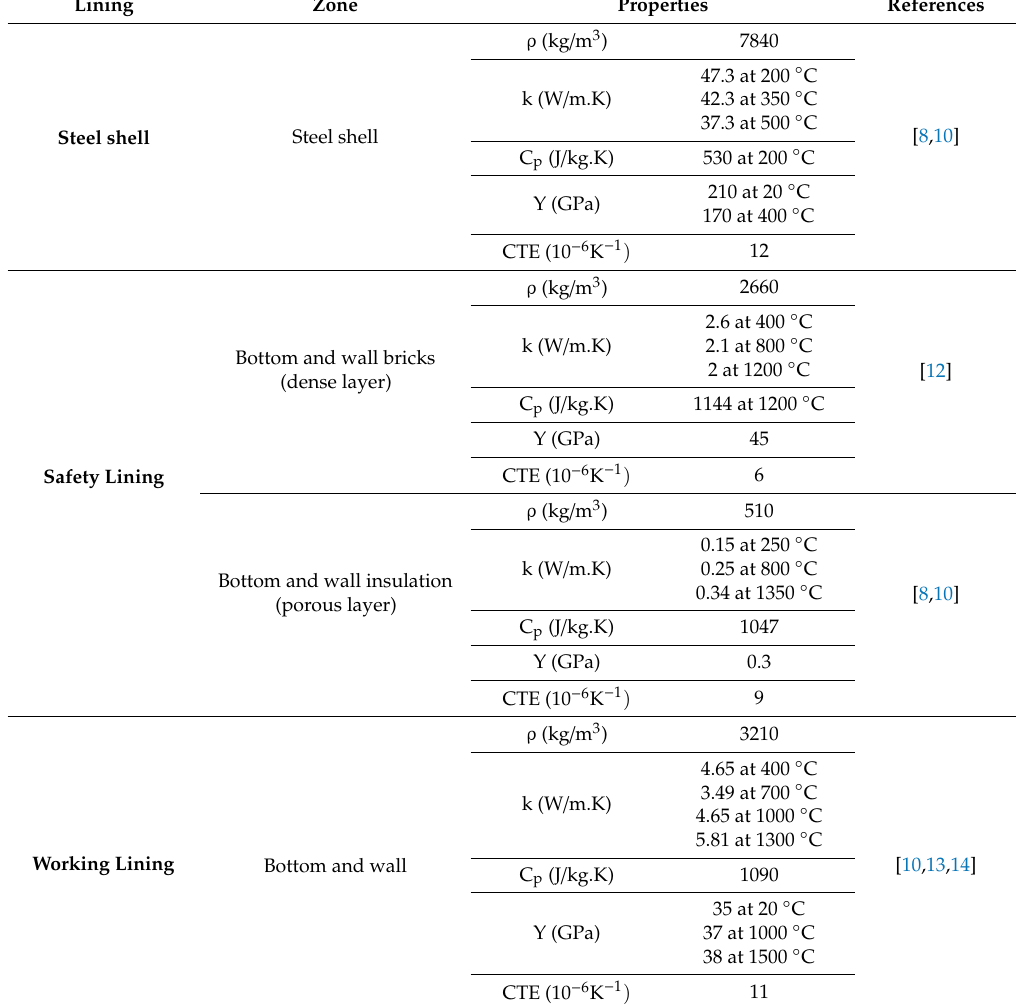
Table 1. Thermophysical properties of materials used in the present